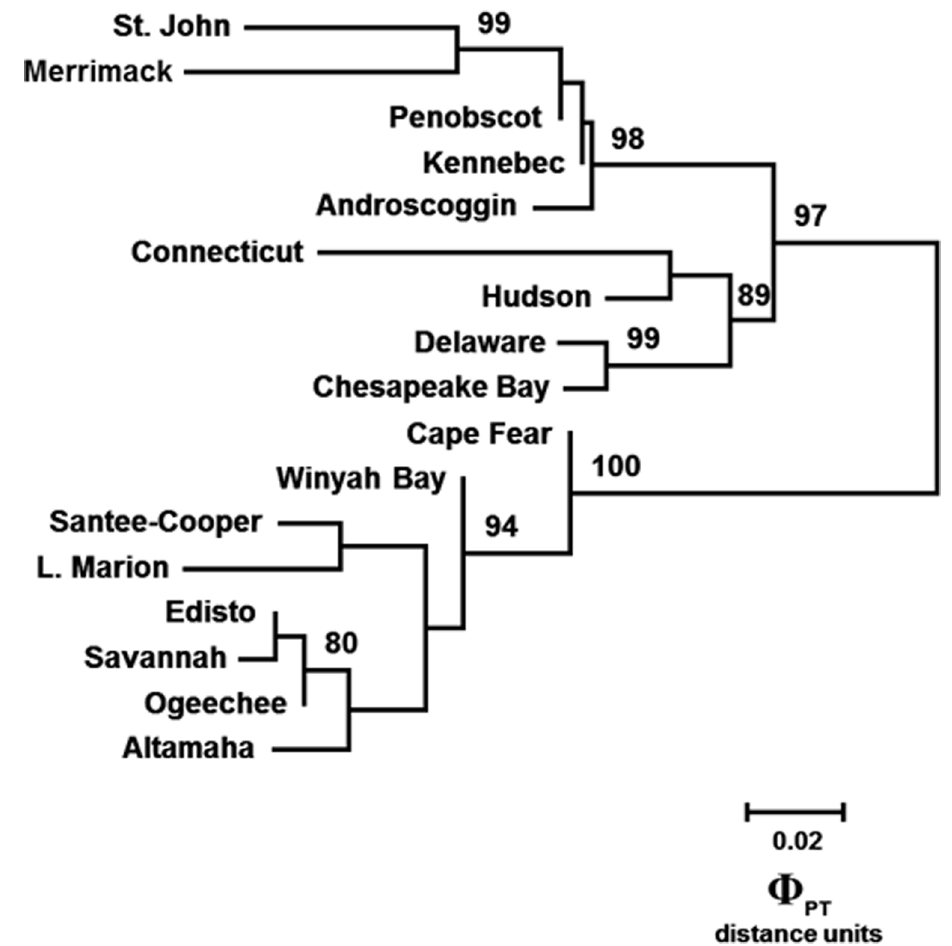
Figure 4. The evolutionary history among 17 collections of shortnose sturgeon ( Acipenserbrevirostrum ) surveyed at 11 polysomic microsatellite DNA loci inferred from the pair-wise W PT distance matrix using the Neighbor-Joining method [56] . Phylogenetic analyses were conducted in MEGA4 [57].